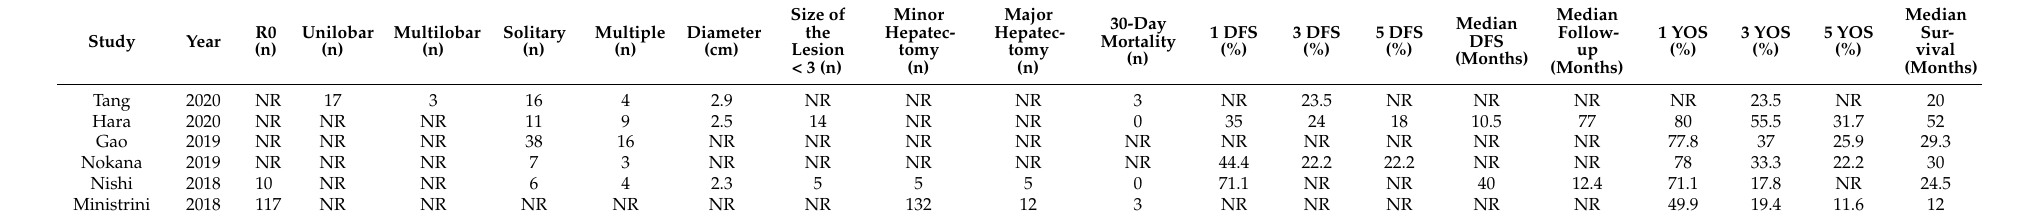
Table 2. Metastasis characteristics and survival